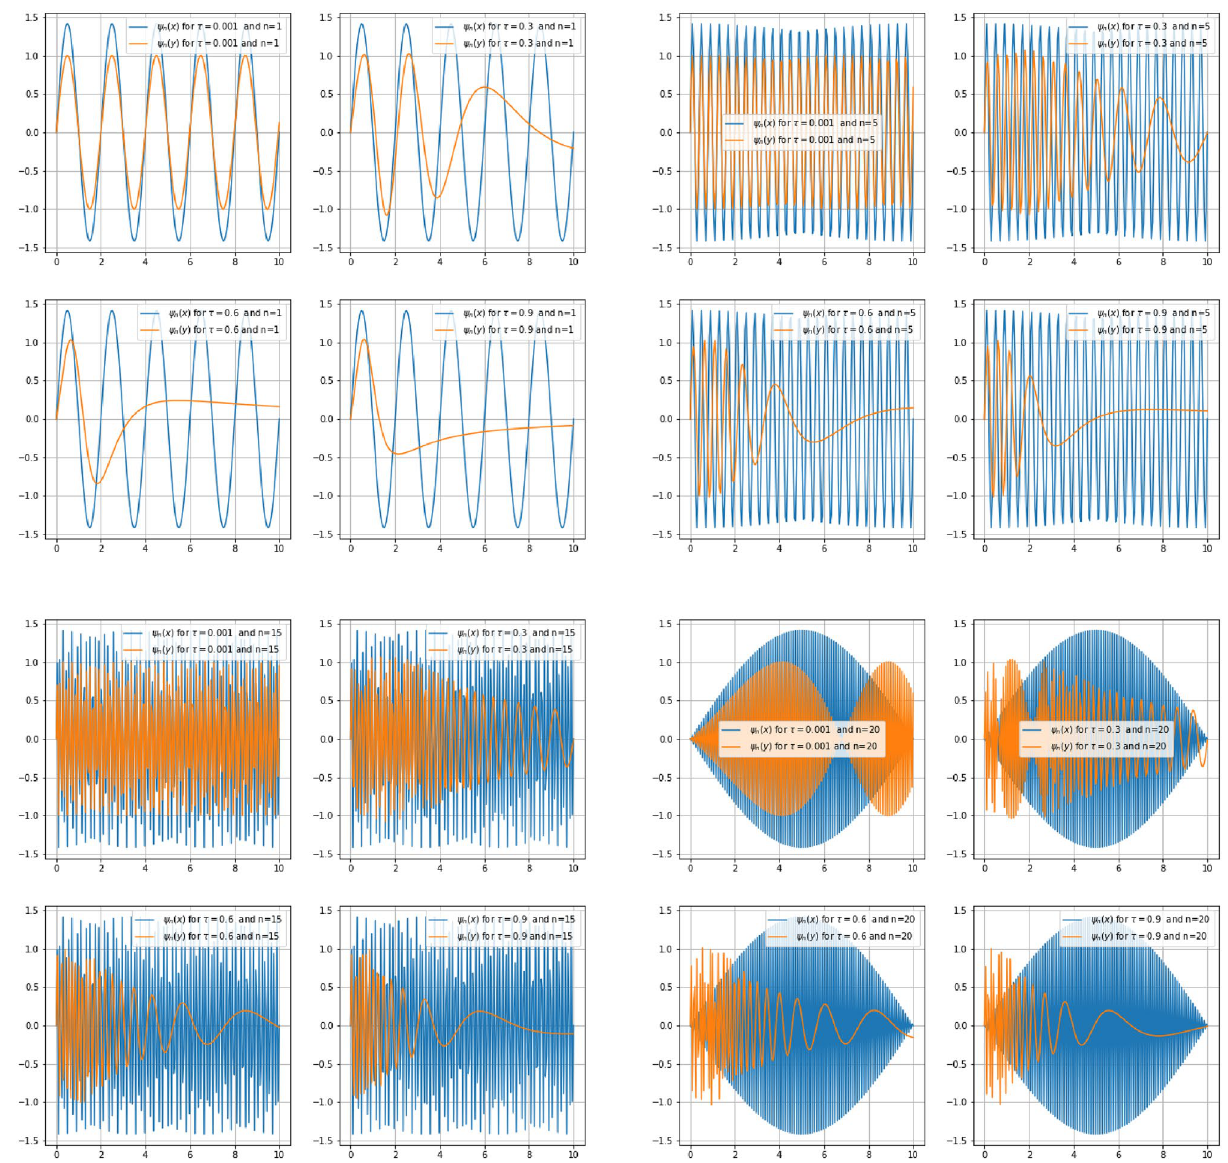
Figure 9. Comparison graph of ψ n ( x s ) and ψ n ( y s ) for a particle confined in an infinite square well of length 1 deformed by the gravity parameter τ in ys a =